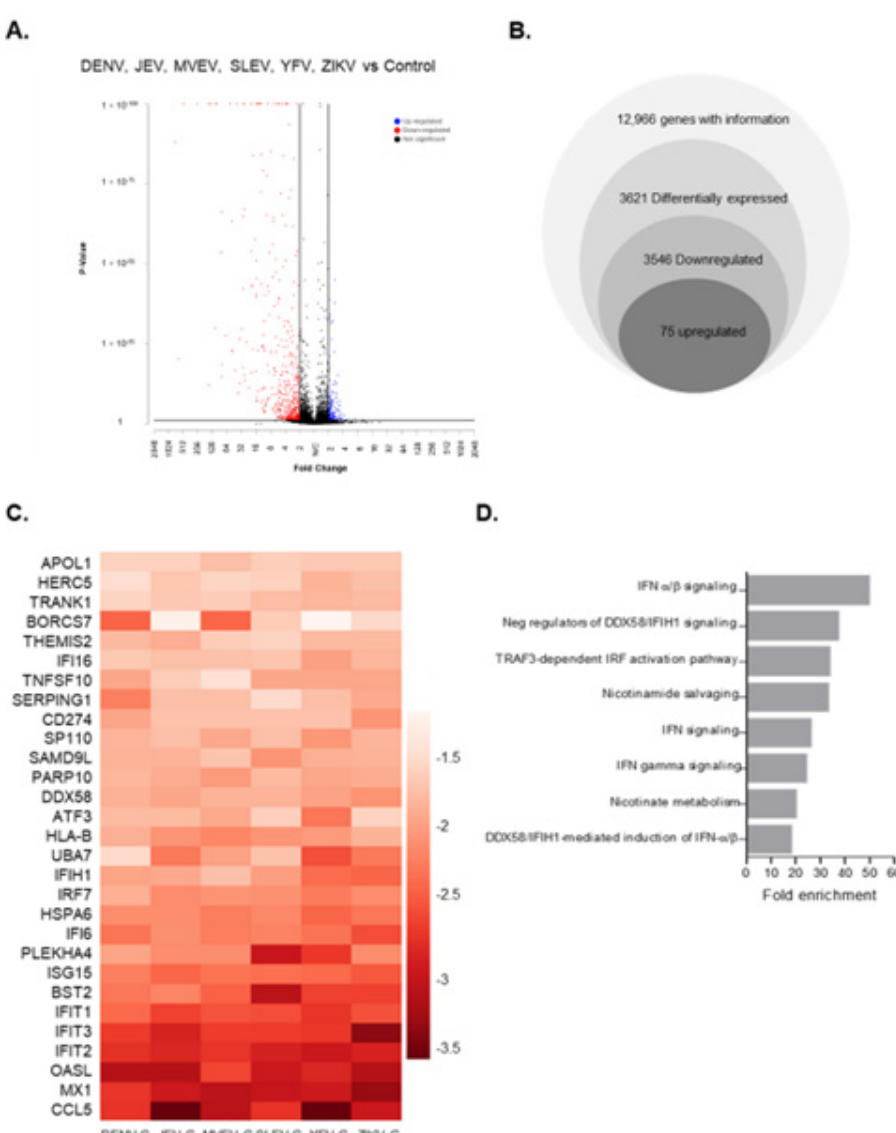
Figure 2. Global gene expression changes in capsid-expressing cells. A549 cells were transduced with lentiviral vectors expressing AcGFP alone or AcGFP and myc-tagged capsid proteins. Cells were collected at 48 h post-transduction, and then total RNA was extracted and processed for RNA-sequencing. Shown are the global gene expression changes common amongst all capsid-expressing cells relative to control (AcGFP). ( A ) Volcano plot displaying differentially expressed genes. Differentially expressed genes with >2-fold changes and with a p -value ≤ 0.01 are shown. Blue: upregulated; red: downregulated; grey: not significant. ( B ) Total common gene expression changes in capsid-expressing cells. All genes with a p -value of ≤ 0.01 are included. In total, 3621 genes were differentially expressed (>2-fold change). ( C ) Top 30 downregulated genes in cells transduced with flavivirus capsids. Each panel in the heat map represents a particular gene, and the intensity of the colour represents fold change relative to control (all values underwent log 10 transformation). ( D ) Gene ontology enrichment analysis of common differentially expressed genes (DEGs) among capsids. Biological pathways were determined by individually submitting DEG lists of downregulated genes to the online bioinformatics server (geneontology.org) using the annotation data set “Reactome pathways”. Shown are the top eight enriched